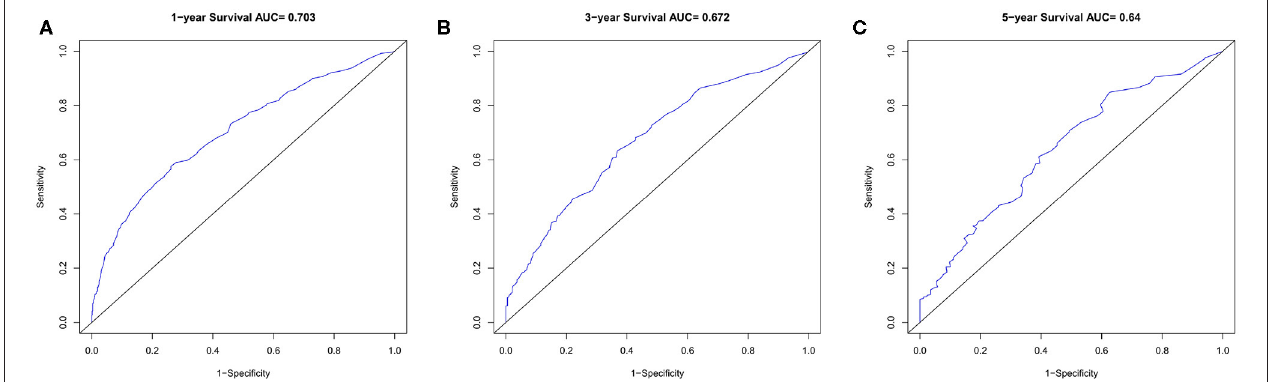
FIGURE 7 | The ROC curves in verification cohort. (A) 1-year, (B) 3-years, (C) 5-years survival ROC